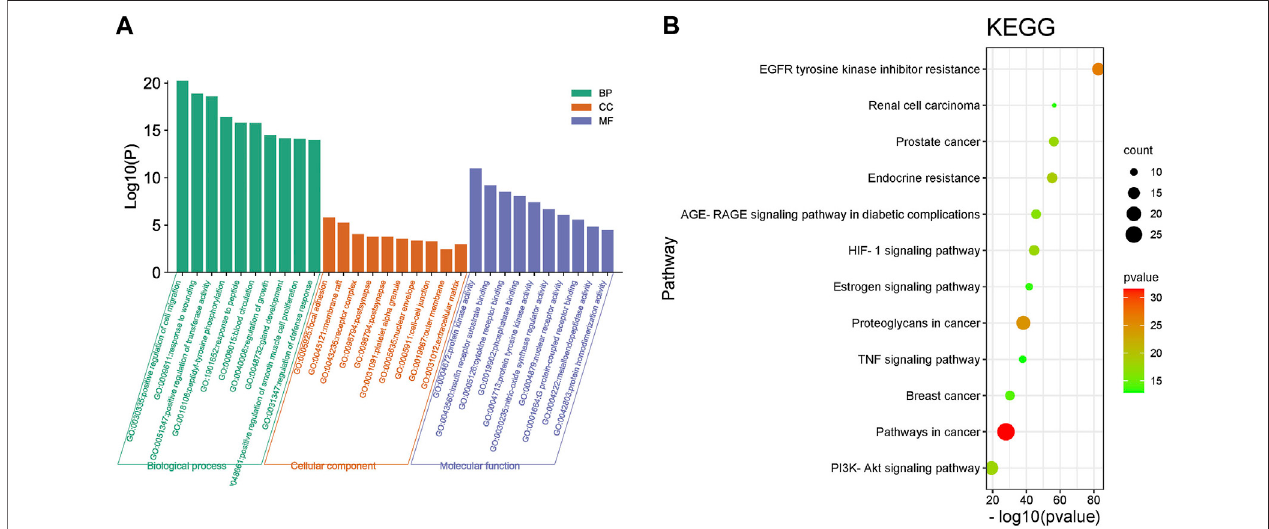
FIGURE 8 | GO (A) and KEGG pathway (B) enrichment analysis of results for CVD treatment of HJP.